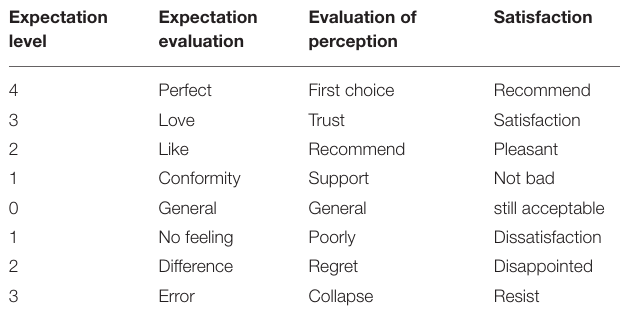
TABLE 1 | Example of value evaluation dictionary